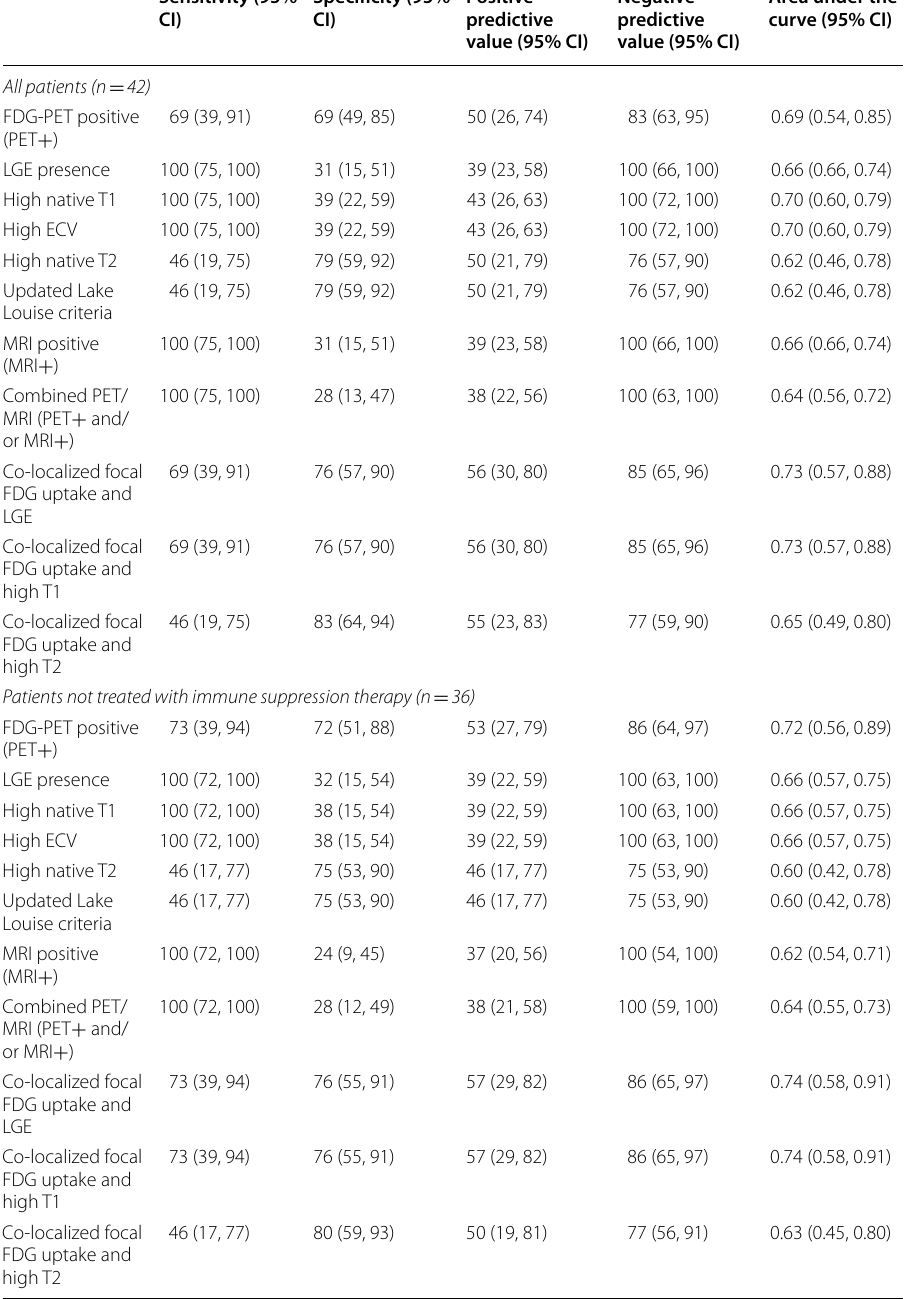
Table 3 Diagnostic accuracy of PET/MRI findings for cardiac